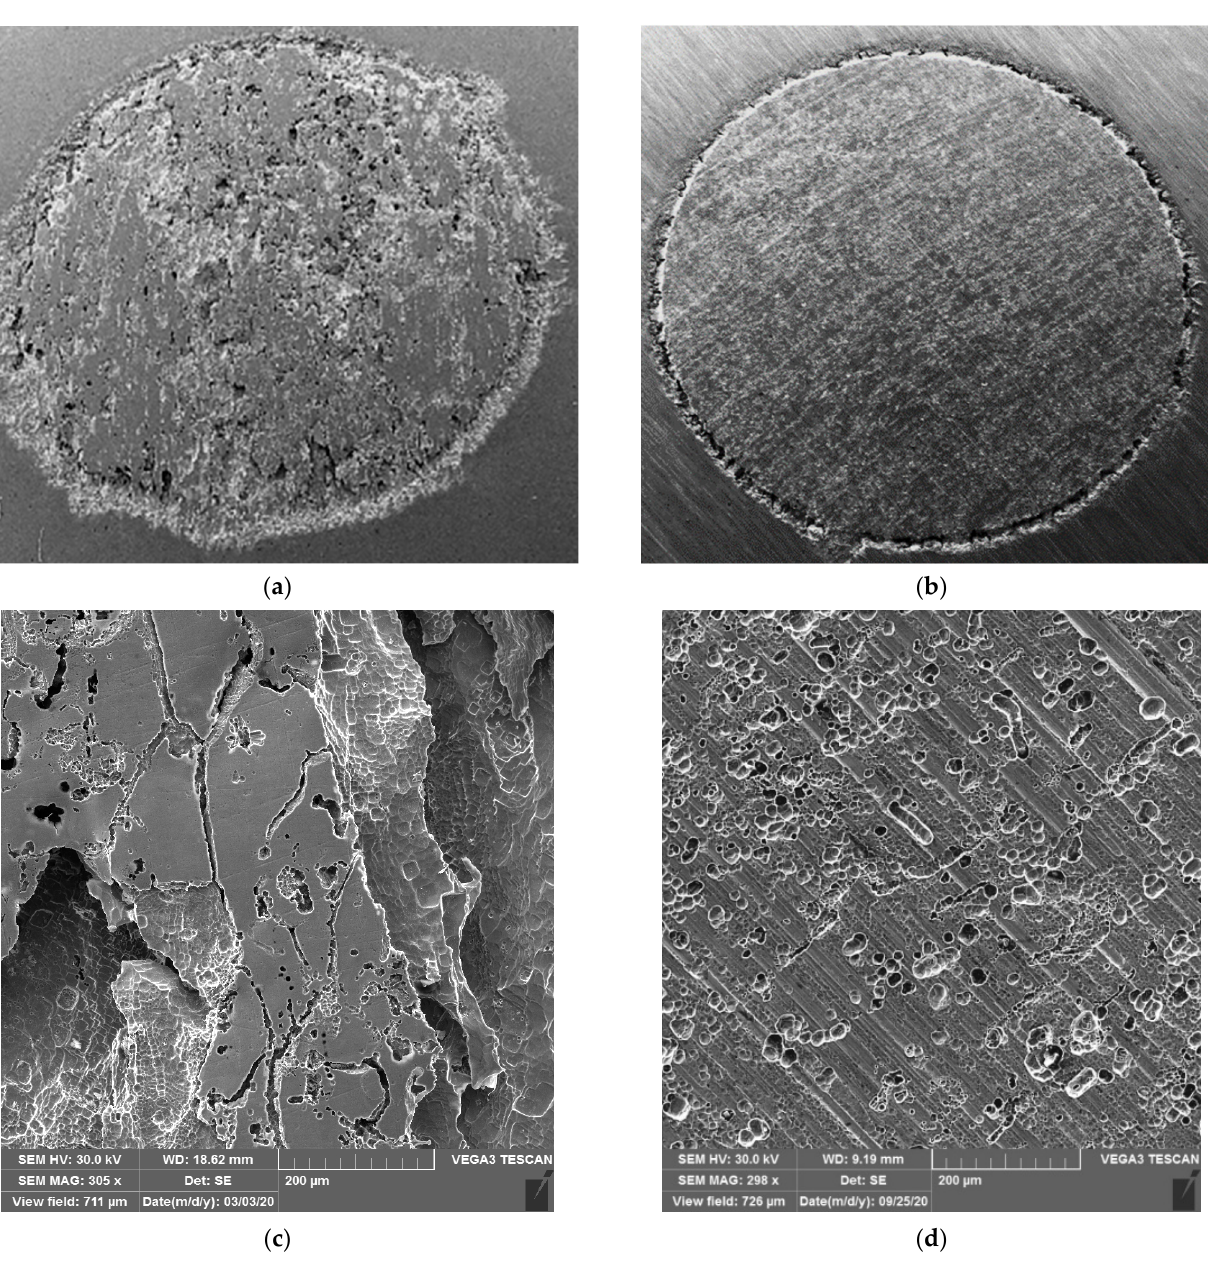
Figure 4. SEM topography of the surface after potentiostatic stress tests at 2 V SHE for AISI 442 steel sample: ( a ) macrography, magnitude 5×; ( c ) micrography, magnitude 300×; and AISI 446 steel sample: ( b ) macrography, magnitude 5×; ( d ) micrography, magnitude 300×.